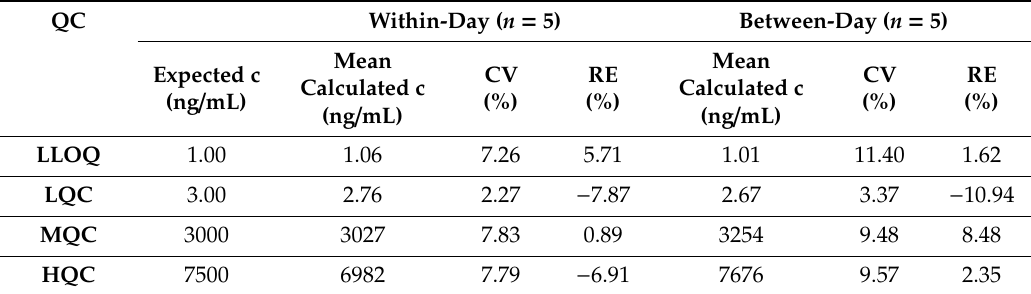
Table 3. Accuracy and precision. c: docetaxel concentration, CV: coe ffi cient of variation, RE: Relative error as measure of accuracy, LLOQ: lower limit of quantitation, LQC: lower quality control, MQC: middle quality control, HQC: higher quality